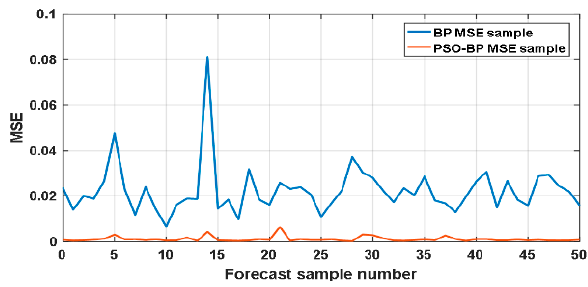
Figure 12. Error contrast of test set’s θ 6 .